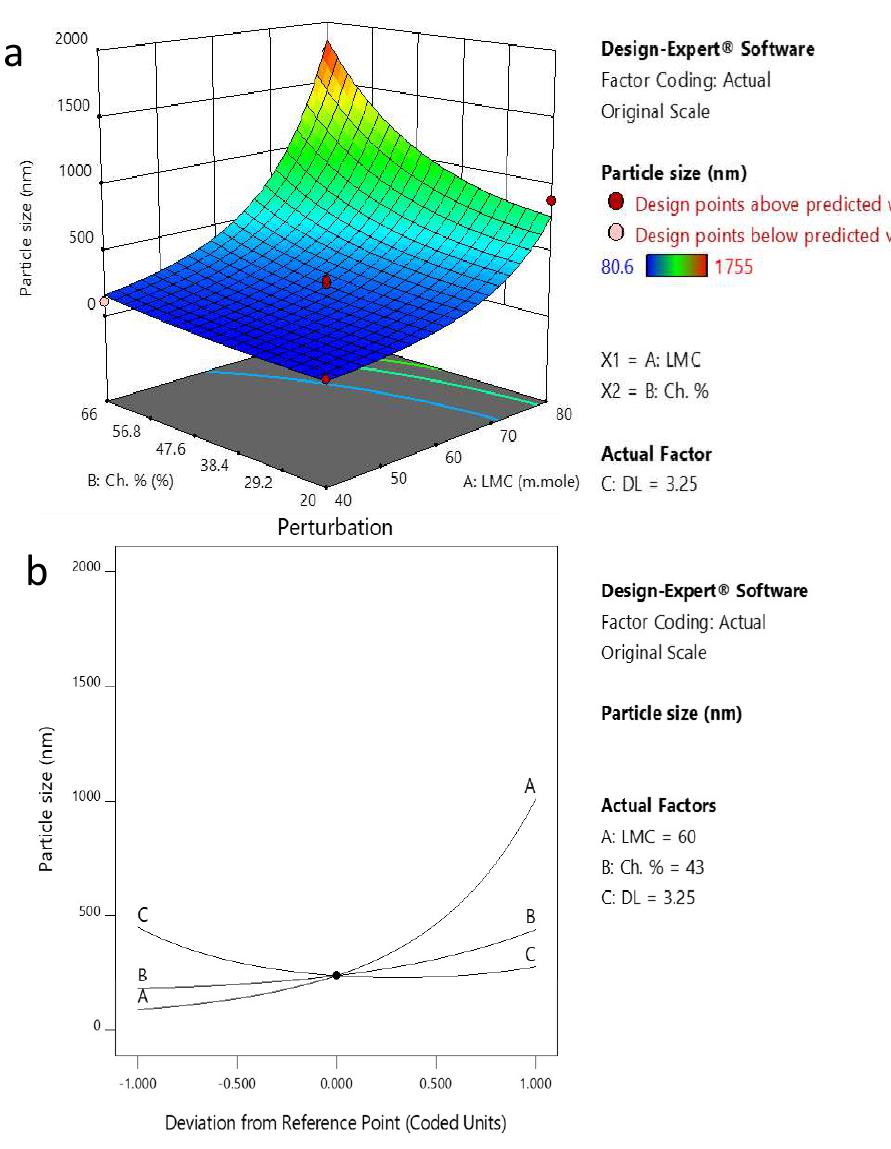
Figure 3. ( a ) 3D plot showing the effect of CH% and LMC on particle size. ( b ) Perturbation blot of factors affecting particle size.